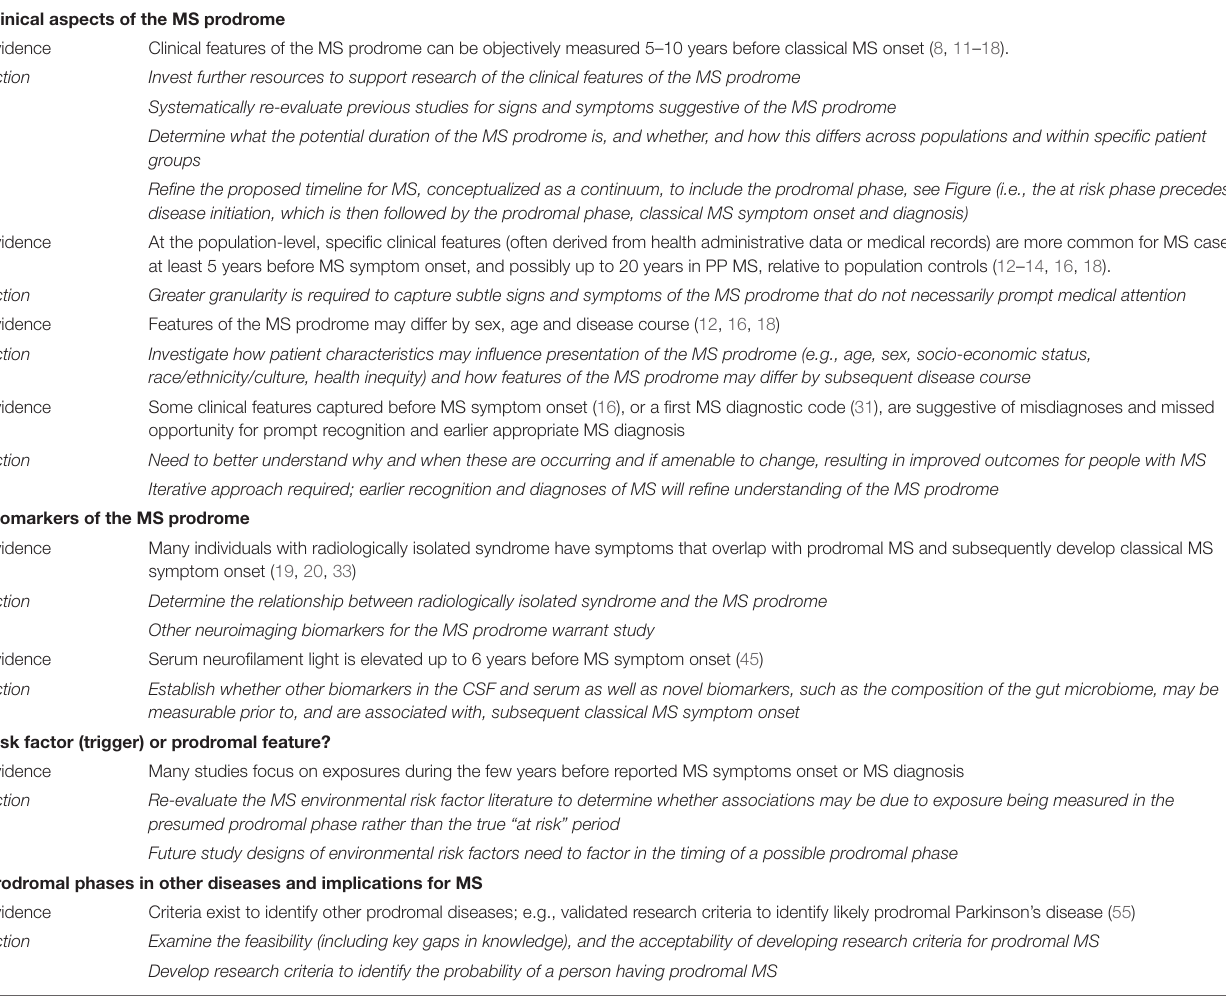
TABLE 1 | Actionable evidence and the MS prodrome: from general to specific examples. Clinical aspects of the MS